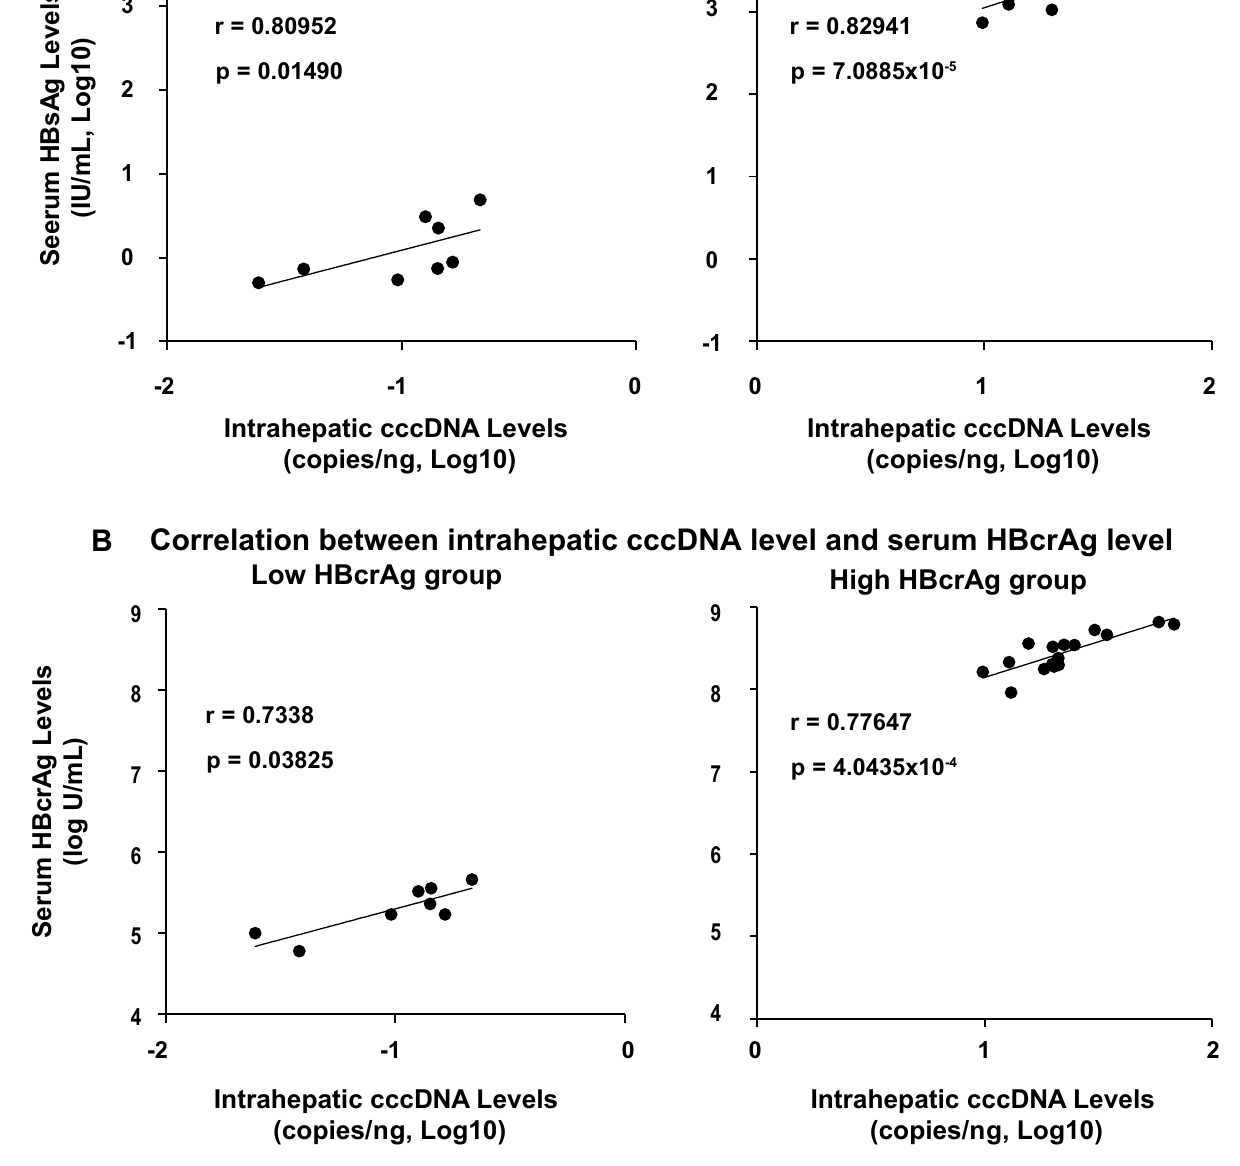
Figure 3. Correlation between intrahepatic cccDNA and serum HBV markers. Twenty-four HBV-infected chimeric mice under various conditions were divided into the HBV infection as during spreading phase of partially infection (n = 8; #1–2, #13–16, #19, #20) and the stable phase of fully infection (n = 16; #3–12, #17–18, #22–24). The cccDNA contents were correlated with ( A ) serum HBsAg and ( B ) serum HBcrAg in each group. Characteristics of each mouse were described in Table